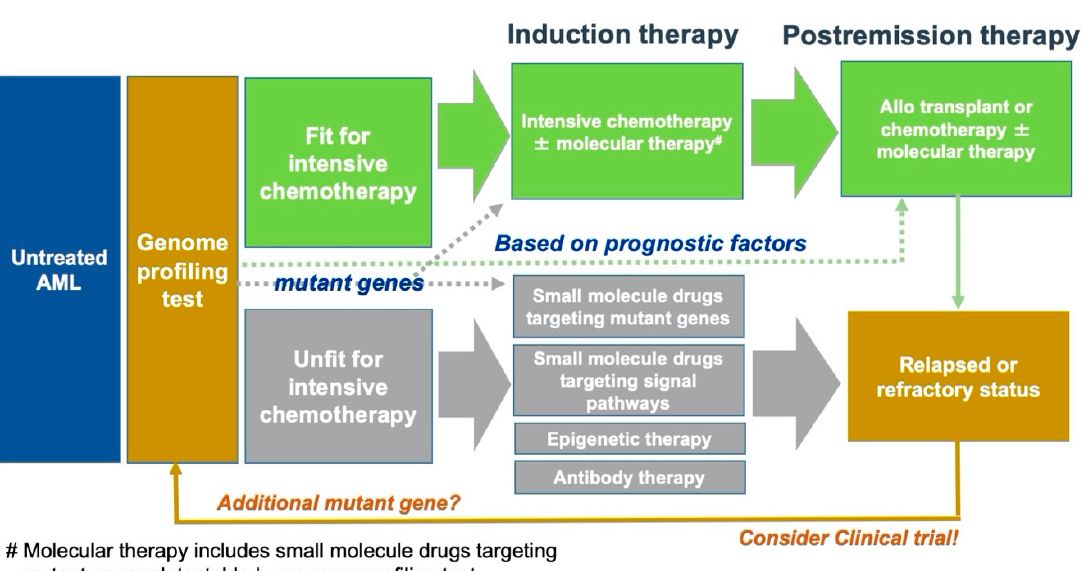
Figure 2. Proposed treatment strategy in AML.